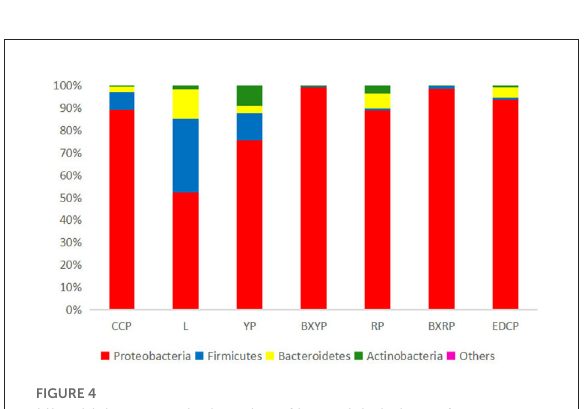
FIGURE4 Microbial community bar plot of bacterial phylum of seven samples (for the best view, relative abundances of < 0.05% are merged into